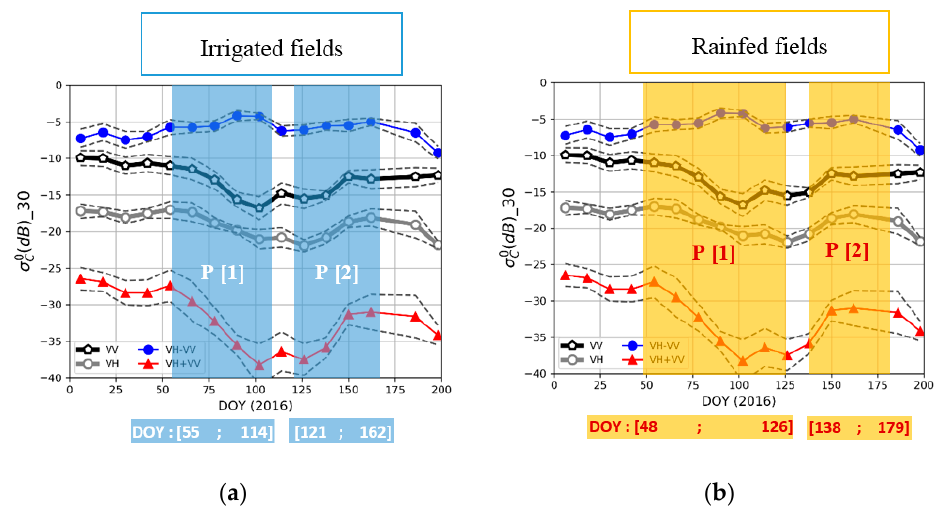
Figure 7. Vegetative periods: P [1] and P [2] for ( a ) irrigated (blue color) and ( b ) rainfed (yellow color) fields superposed to the temporal profiles of the S-1 backscattering coefficients (VV, VH, VH − VV, VH + VV).